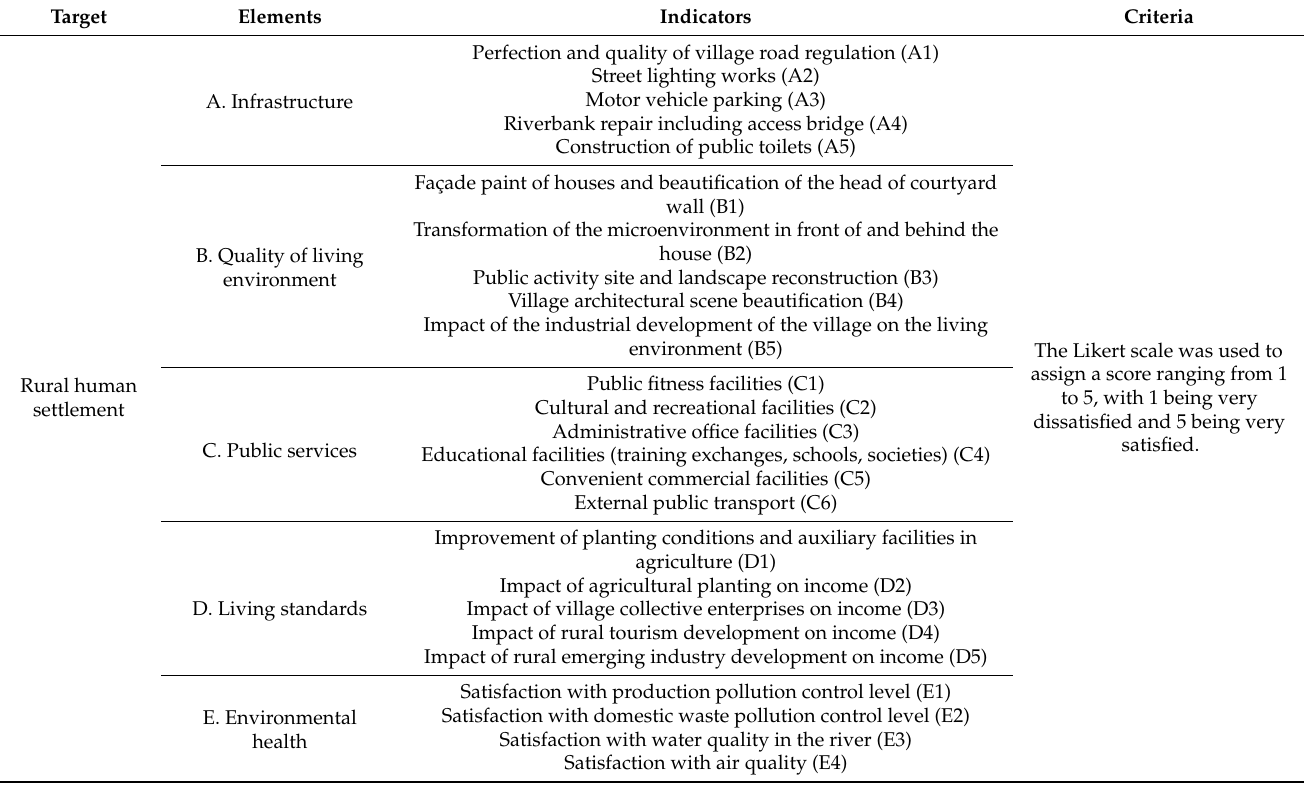
Table 2. Index system of theoretical model of satisfaction evaluation and common factor variance